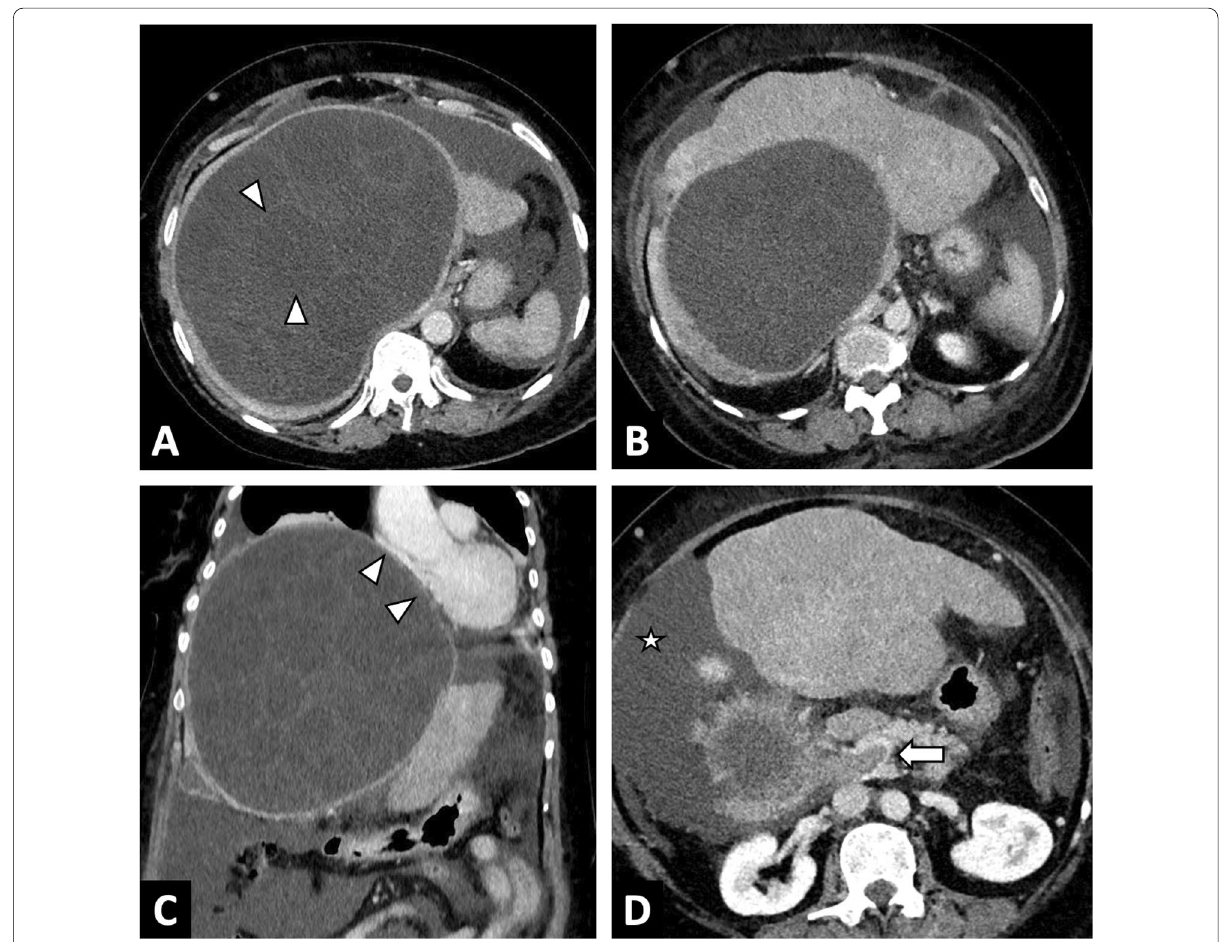
Fig. 13 Large cystic echinococcosis lesion of the right liver in a 54‑year‑old woman revealed by ascitic decompensation. A CT image in the axial plane at the portal phase showing a large cystic echnicoccosis lesion of the right liver. Internal daughter cysts (arrowheads) (CE3a stage). B CT image in the axial plane at the portal phase showing a large right liver cyst complicated by advanced chronic liver disease secondary to Budd Chiari syndrome. Hypertrophy of the left liver lobe and surface nodularity suggestive of advanced fibrosis. C Same examination in the coronal plane. Mass effect of the cystic echinococcosis on the heart chambers (arrowheads). D Same examination in the axial plane, lower slices. Portal thrombosis (arrow) and ascites